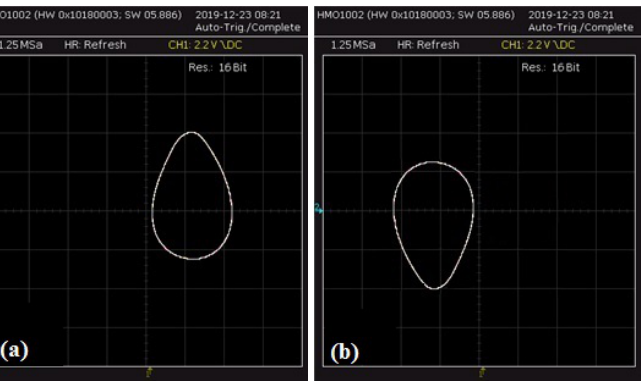
Figure 6. ( a , b ) Experimentally observed coexisting period-1 phase portraits of υ C a = 4 × 10 − 4 , c = 3.846 × 10 − 4 , d = e = 1 and b = 0.2 ( R b = 50 k Ω